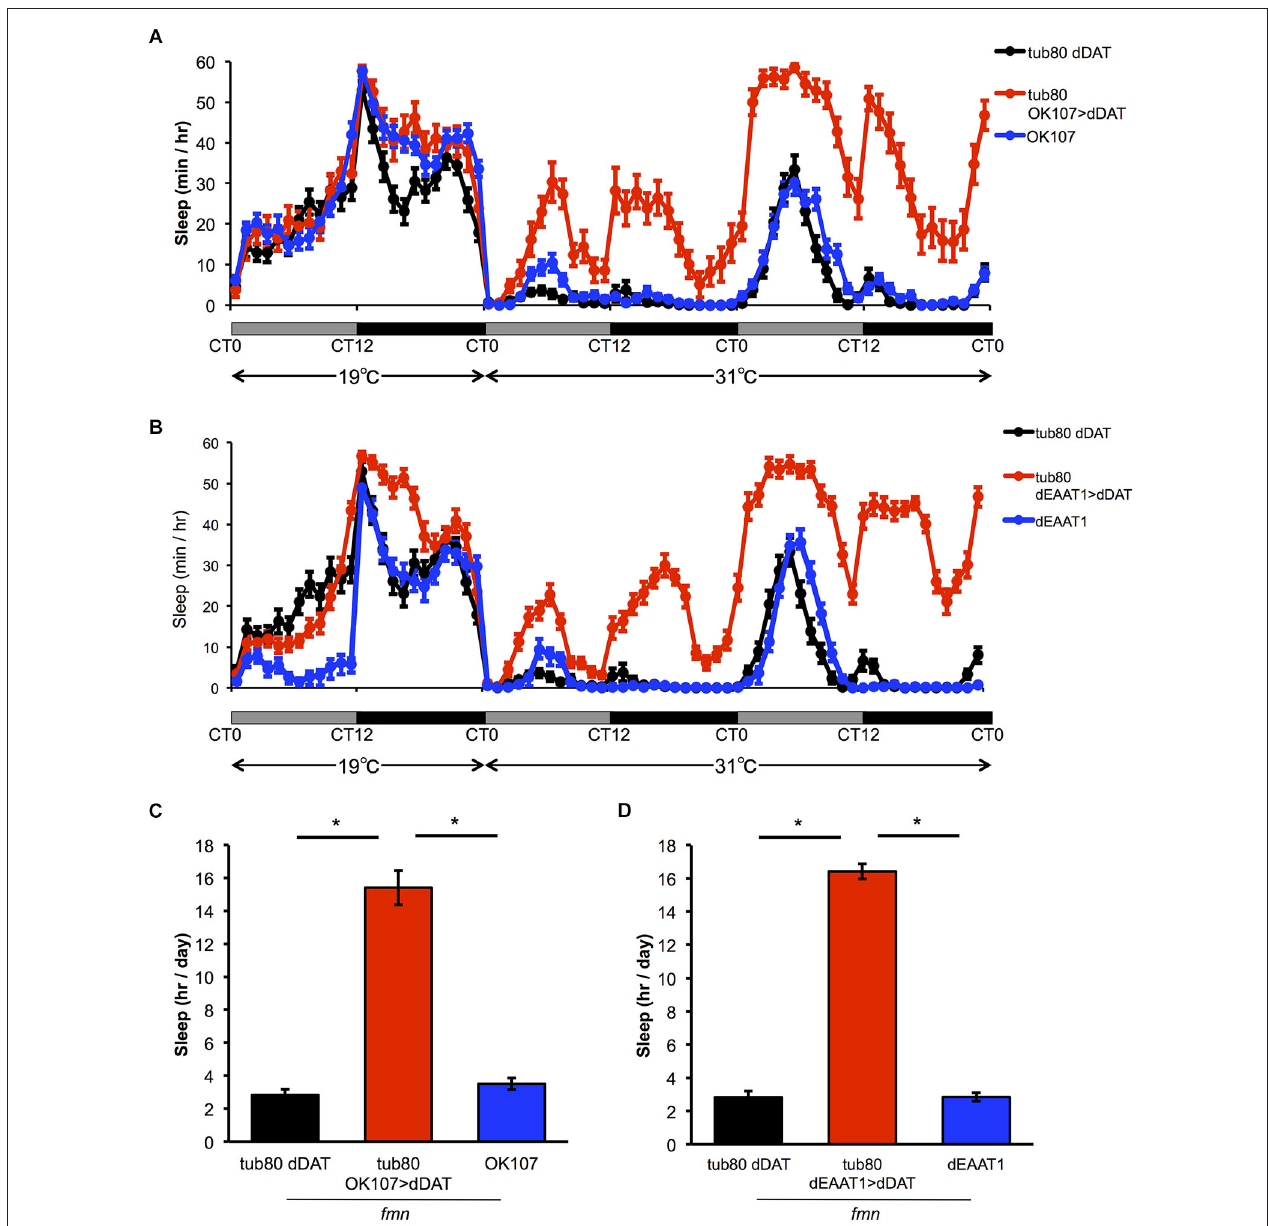
mushroom body using the TARGET system. Daily sleep at 31 ◦ C is shown. (D) Total daily sleep amounts for flies expressing dDAT in glial cells using the TARGET system. Daily sleep at 31 ◦ C is shown. Data are represented as the mean ± s.e.m. * P < 0.05; one-way ANOVA with Tukey-Kramer HSD post hoc test ( n = 32